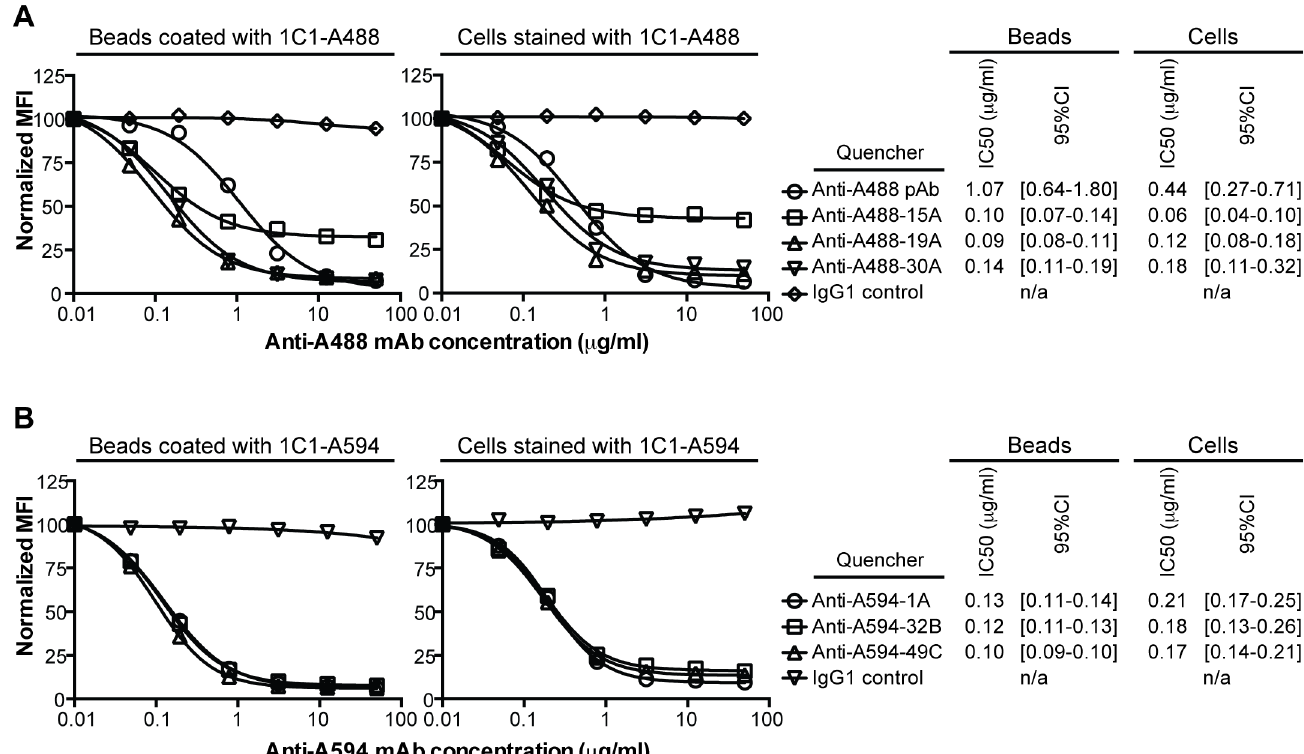
Fig 1. Quenching by anti-Alexa Fluor mAbs. (A) Fluorescence of Alexa Fluor 488 (A488) on microbeads coated with 1C1-A488 or PC-3 cells stained with 1C1-A488 was quenched with a titration of the benchmark, a rabbit anti-A488 polyclonal, or 1 of 3 anti-A488 mAbs. One representative experiment of multiple is shown. (B) Fluorescence of Alexa Fluor 594 (A594) on microbeads coated with 1C1-A594 or PC-3 cells stained with 1C1-A594 was quenched with a titration of 1 of 3 anti-A594 mAbs. One representative experiment of multiple is shown. (A, B) Median fluorescence intensities (MFIs) at each anti-A488 or anti-A594 mAb concentration were normalized against a buffer control. The chimeric IgG1 isotype control was used as a non-quenching mAb control. The IC50 values (microgram/ml) of quenching and the corresponding 95% confidence intervals (95% CI) are listed for both the microbead- and cell- based